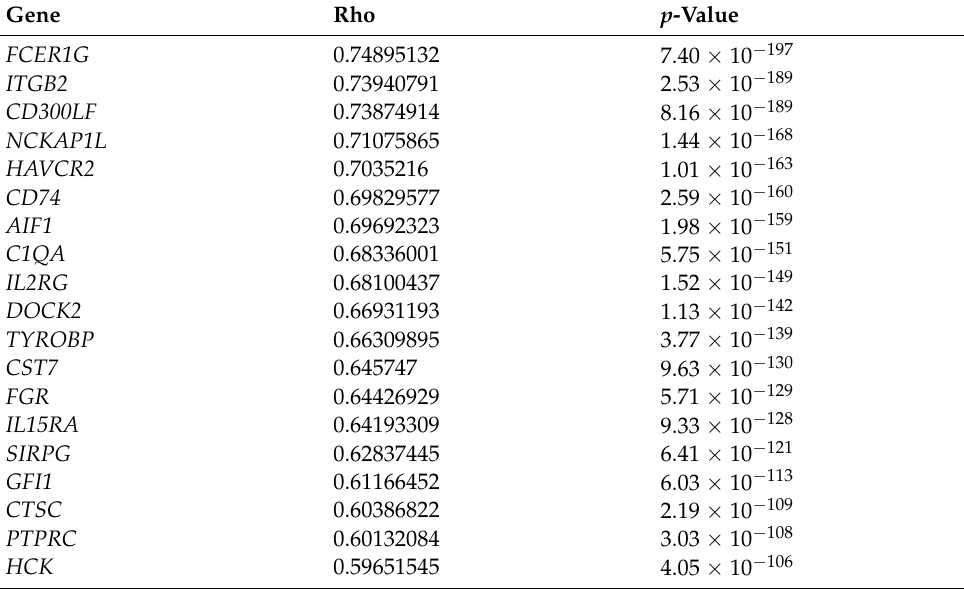
Table 1. Macrophage enrichment score was correlated with phagocyte